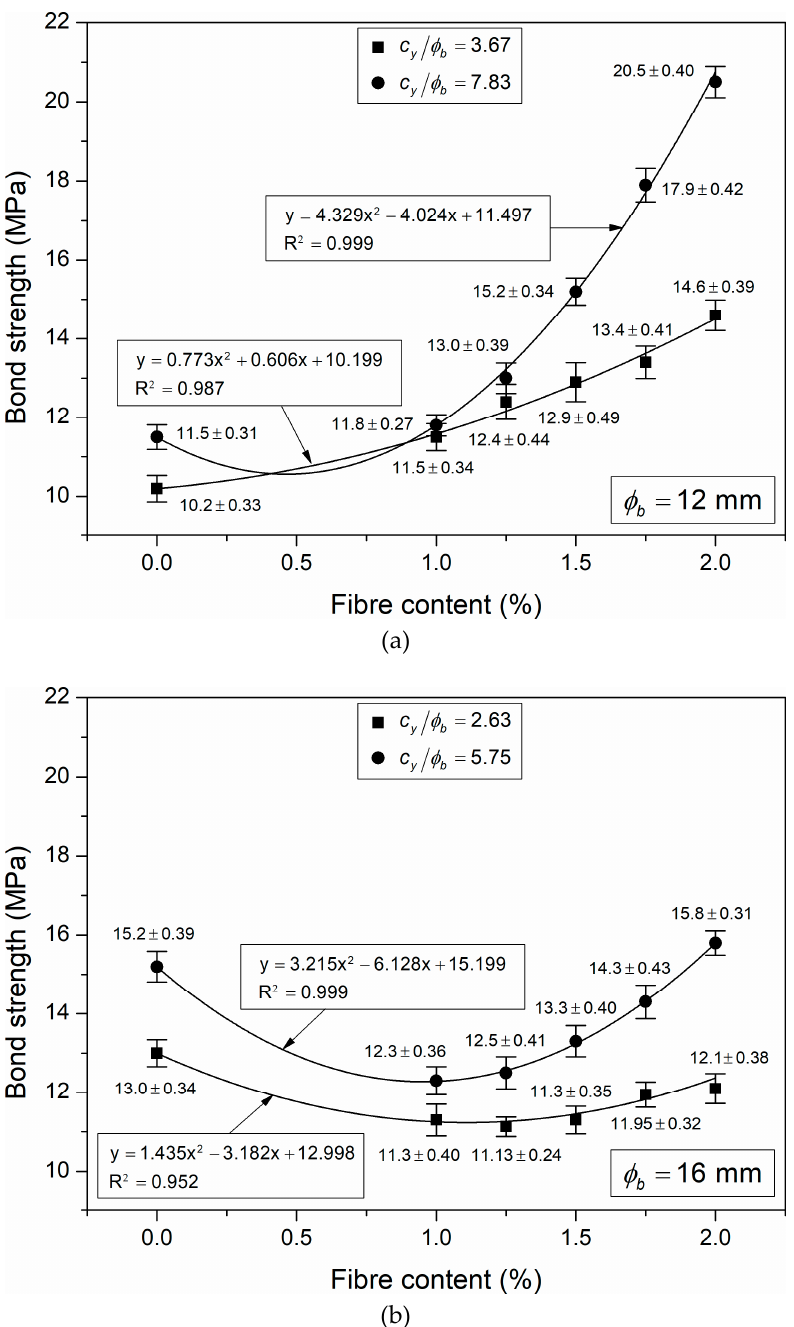
Figure 3. Variation in bond strength with fibre content for different bar diameters ϕ b and relations c y / ϕ b (a) 12 mm, (b) 16 mm.